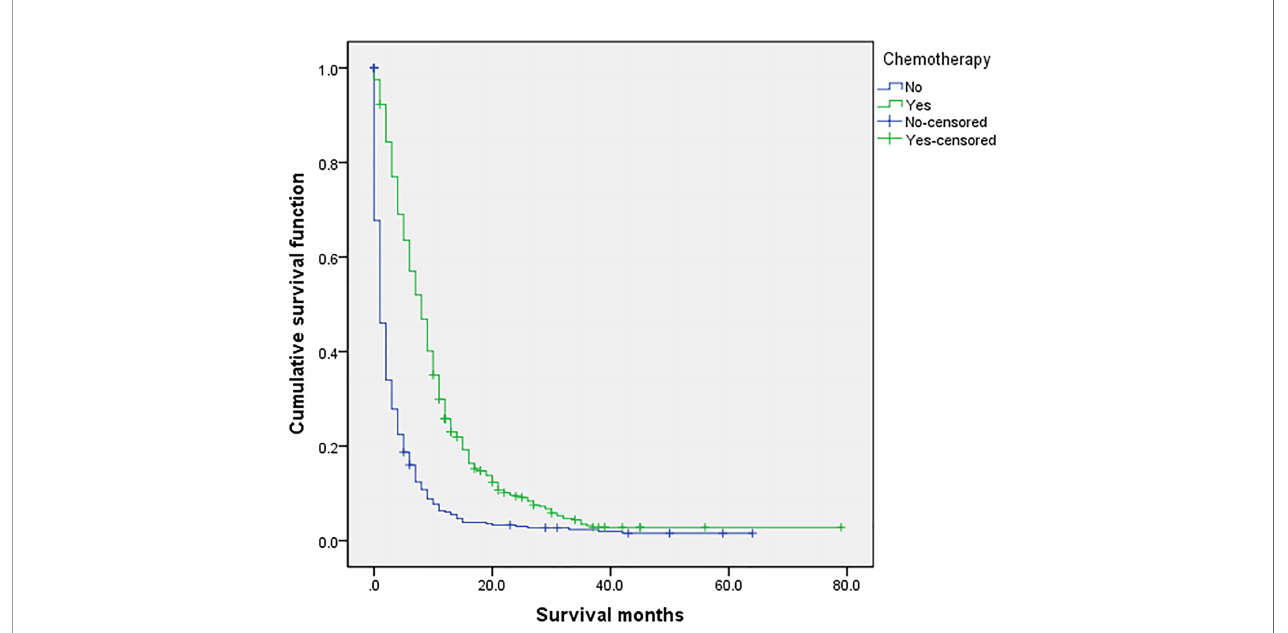
FIGURE 5 | Univariate analysis of with or without chemotherapy. In the organ metastasis group (n = 870), univariate analysis of with or without chemotherapy showed that P < 0.001 was obtained by Kaplan – Meier survival analysis log rank (mental Cox). There was signi fi cant difference between the two groups.